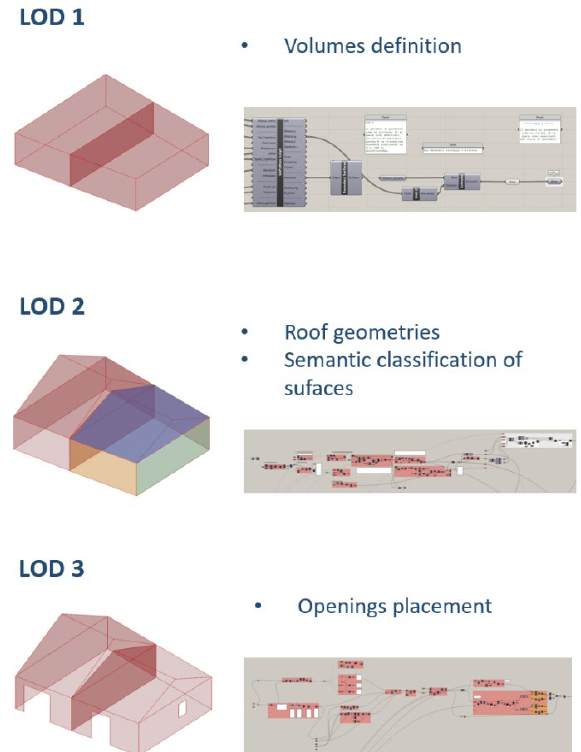
Figure 5 . Parametric CIM modeling phases (LOD 0 – 3)